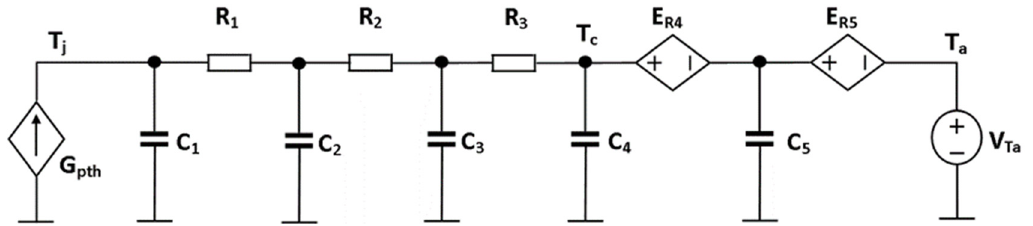
Figure 1. Circuit representation of the formulated thermal